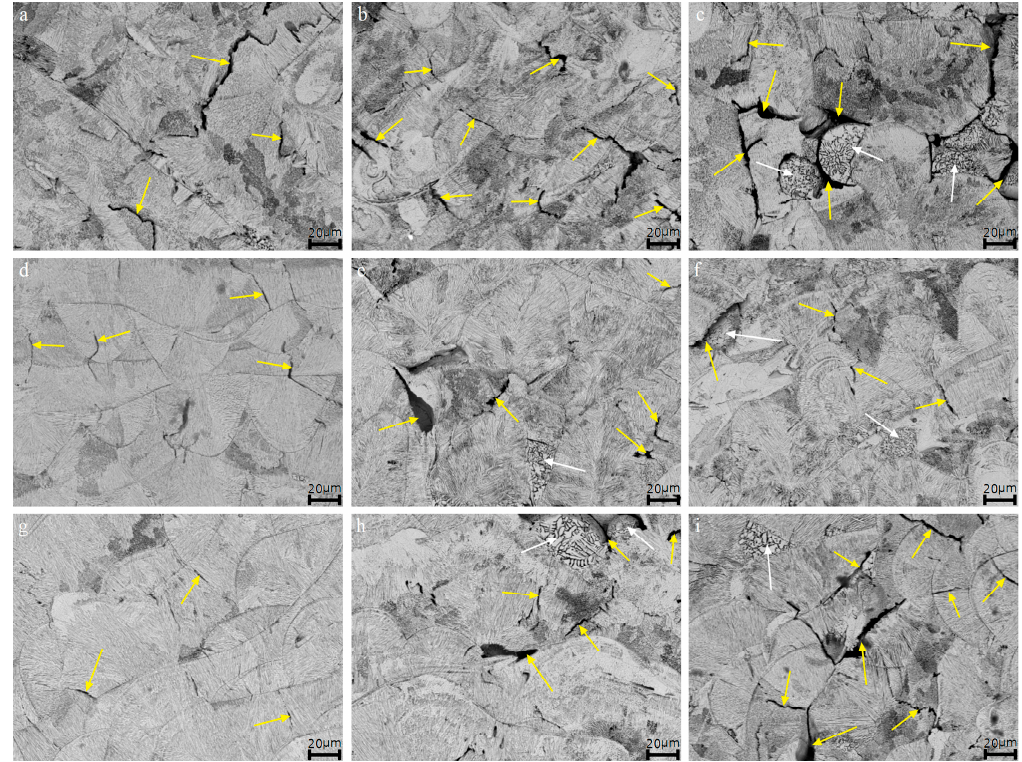
Figure 5. Microstructures of three SLM SS316L samples at different cross-sections ( a ) fine powder XY plane, ( b ) coarse powder XY plane, ( c ) raw powder XY plane, ( d ) fine powder YZ plane, ( e ) coarse powder YZ plane, ( f ) raw powder YZ plane, ( g ) fine powder XZ plane, ( h ) coarse powder XZ plane and ( i ) raw powder XZ plane.